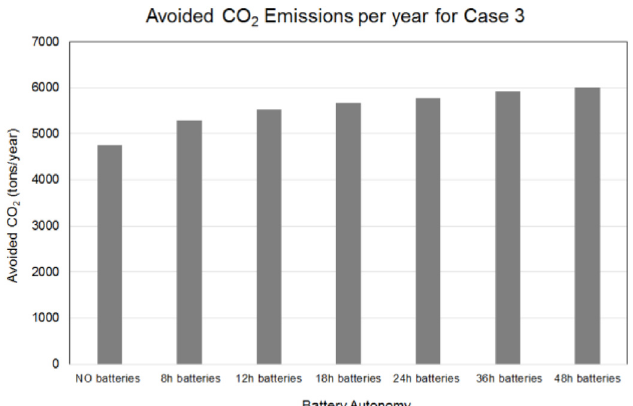
Fig. 17. Annual reduction of carbon dioxide emissions due to hybrid power station operation for case